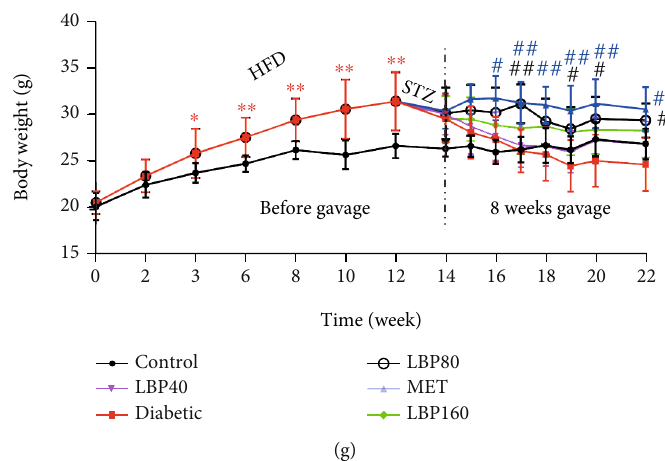
Figure 1: E ff ects of LBP on blood glucose and insulin resistance of diabetic mice: (a) fasting glucose level before gavage, (b) fasting glucose level after 8 weeks of treatment, (c) random glucose level before gavage, (d) random glucose level after 8 weeks of treatment, (e) fasting insulin level after 8 weeks of treatment; (f) homeostasis model assessment-insulin resistance (HOMA-IR) index after 8 weeks of treatment; (g) body weight monitoring. Data represent the mean ± SD ( n = 6 -9 mice per group). ∗ Control vs. other groups, ∗ p < 0 : 05, ∗∗ p < 0 : 01 ; # diabetic vs. other groups, # p < 0 : 05, ## p < 0 : 01 ; $ MET vs. LBP-80, $ p < 0 : 05, $$ p < 0 : 01 ; ns means no signi fi